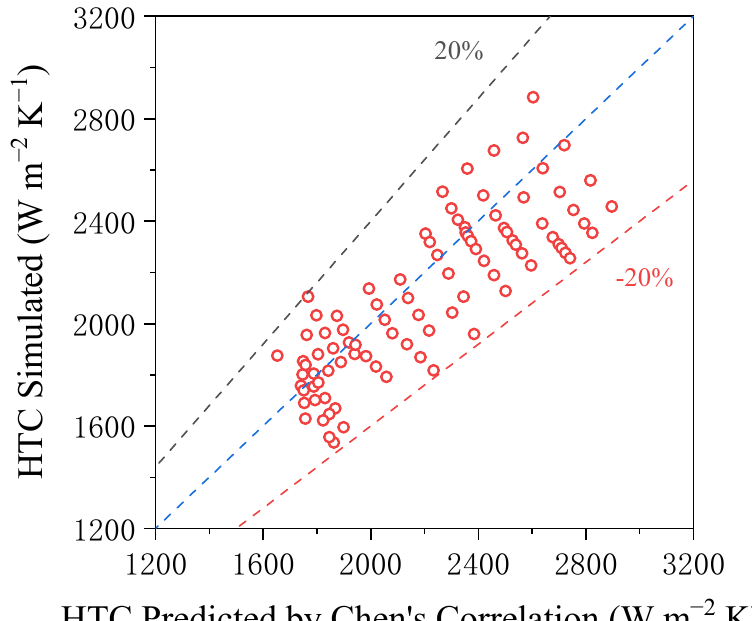
Figure 6. Heat transfer coefficient comparisons between simulated results and Chen’s correlation.